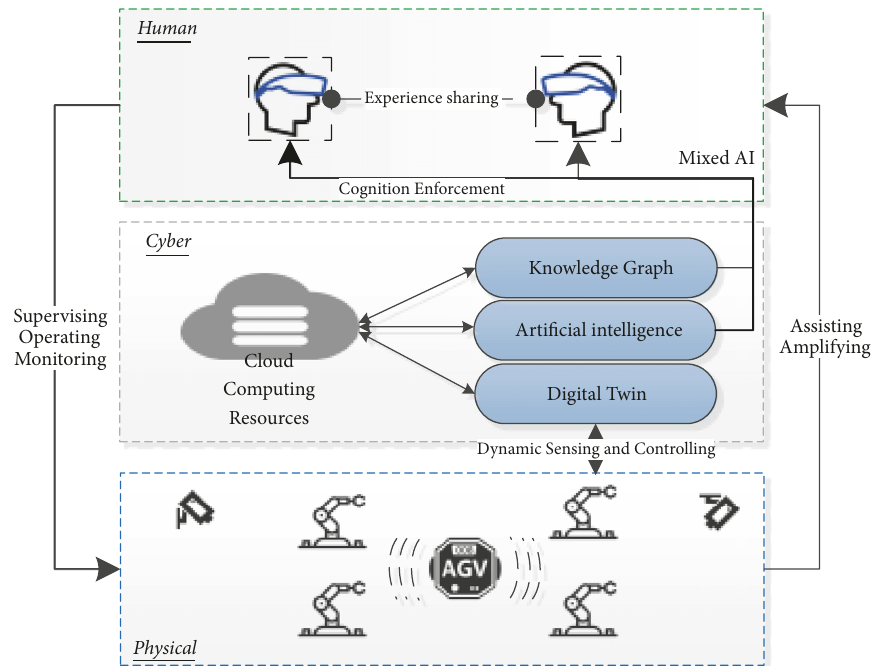
Figure 1: The framework of integrating human in the CPS loop.